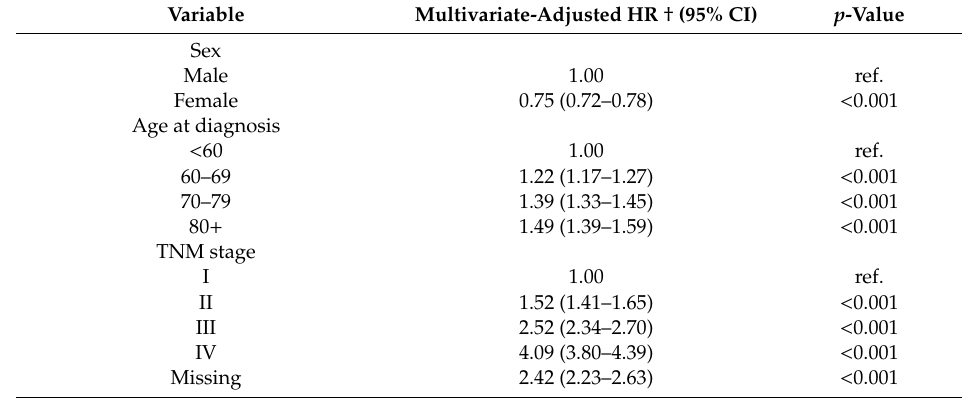
Table 3. HR and 95% CI of the association of diabetes, antidiabetic medication use and overall